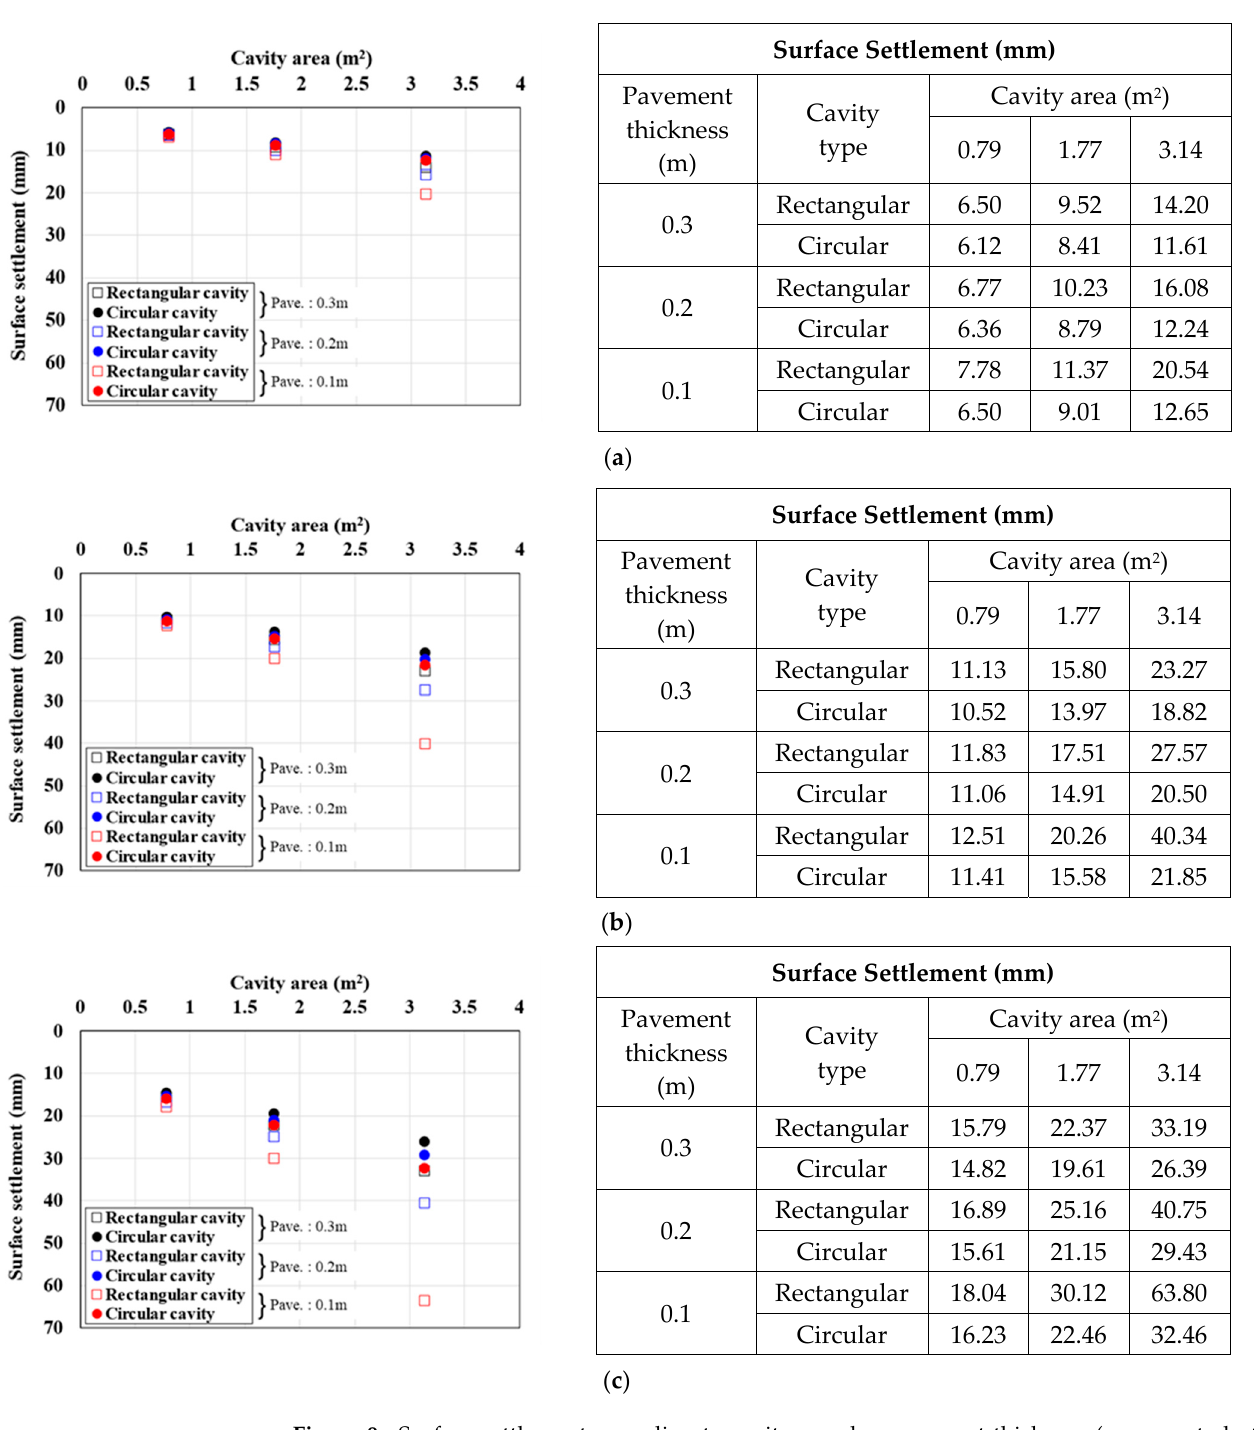
Figure 8. Surface settlement according to cavity area by pavement thickness (pavement elastic mod- ulus: 1000 MPa). Traffic load: ( a ) 12.7, ( b ) 25.4, and ( c ) 38.1 kN/m 2 .